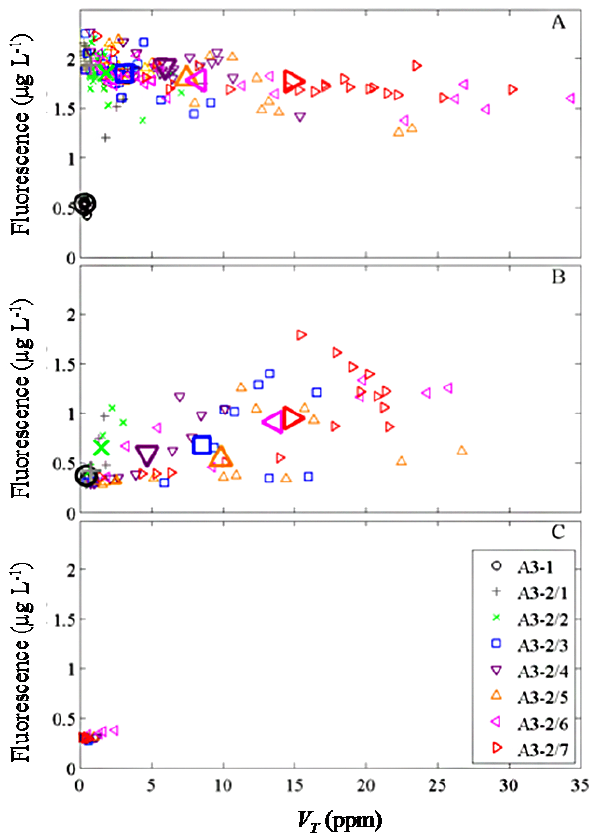
Figure 8. Scatter plots of fluorescence and V T for the three layers: surface to base of ML (A) , base of ML to 200 (B) , and > 200m (C) . Large symbols indicate the means for a profile in the panel depth range.